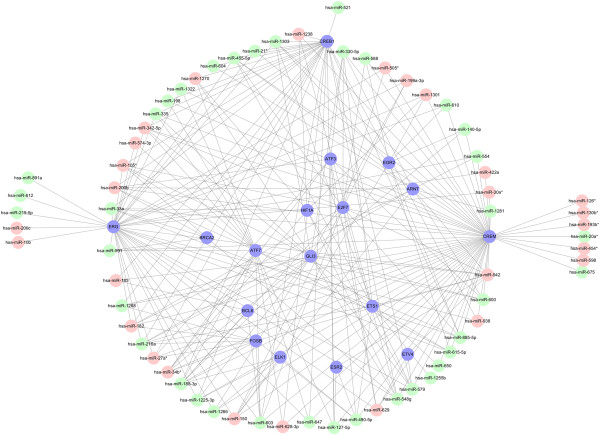
The regulating network of 17 cancer related transcript factors (TFs) and differentially expressed miRNAs. Blue nodes are the TFs, red nodes are the up-regulated miRNAs, and green nodes are the down-regulated miRNAs. Edges represent the interactions between TFs and miRNAs.